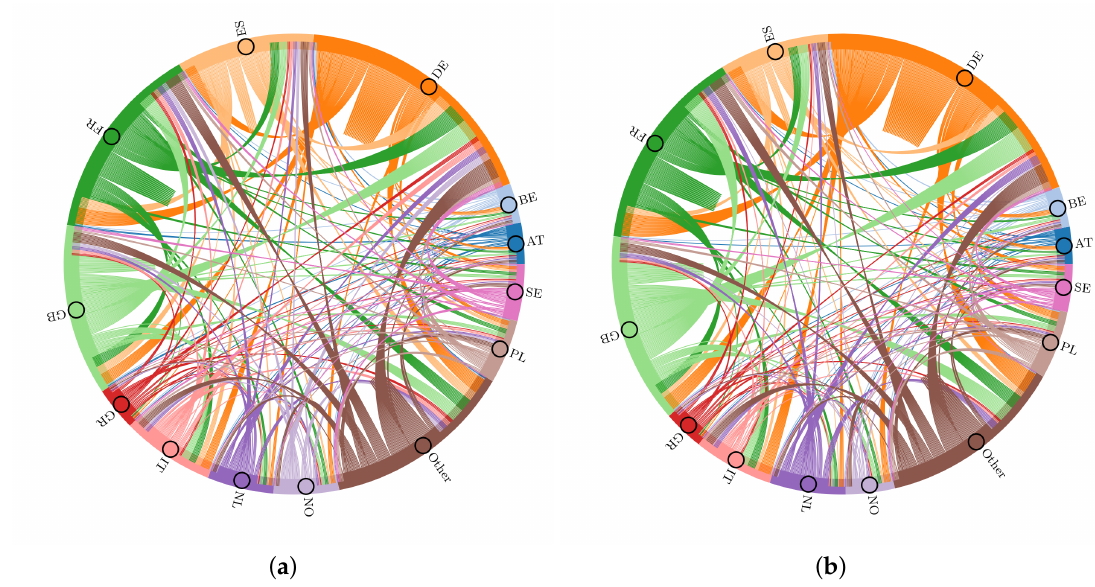
Figure 5. Average interconnecting flow between the 12 strongest exchanging countries. Remaining countries are grouped into “Other.” A lookup table for the full country names is provided in Appendix A. These aggregated source-sink relations count for both MP and EBEs. The flow allocation leads to broad connections between countries that are geographically far apart, and neighboring countries reveal the strongest interconnections. ( a ) shows the full allocation, and ( b ) allocates the flow induced by wind power only. This allocation accounts to 69% of the full cross border flow. Countries along the North Sea coast where most of the wind production is situated, dominate the